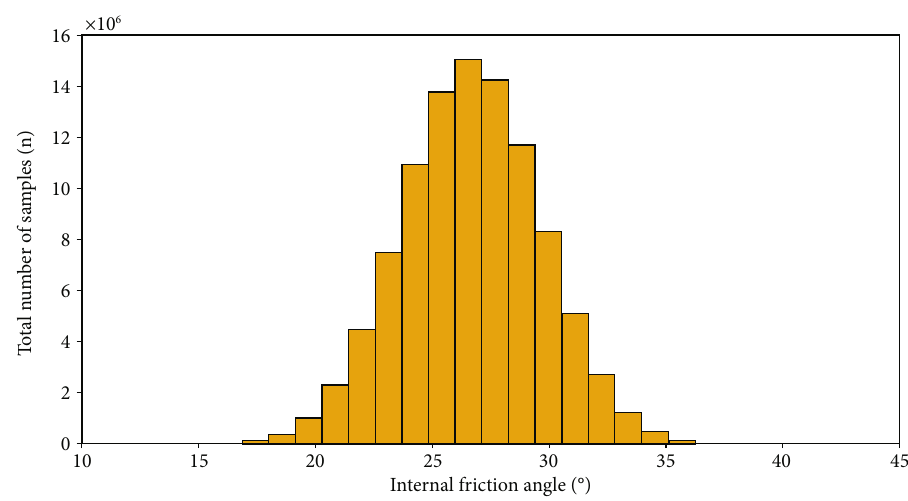
Figure 13: Statistical histogram of internal friction angle